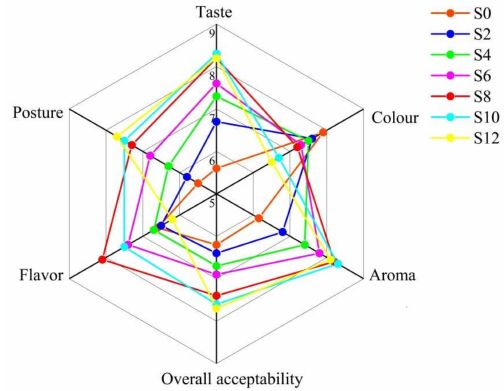
Figure 5. Sensory evaluation of apricot juice in seven fermentation stages. S0, S2, S4, S6, S8, S10 and S12 represent apricot juice samples in seven fermentation periods. The fermentation time is 0 h, 2 h, 4 h, 6 h, 8 h, 10 h and 12 h,